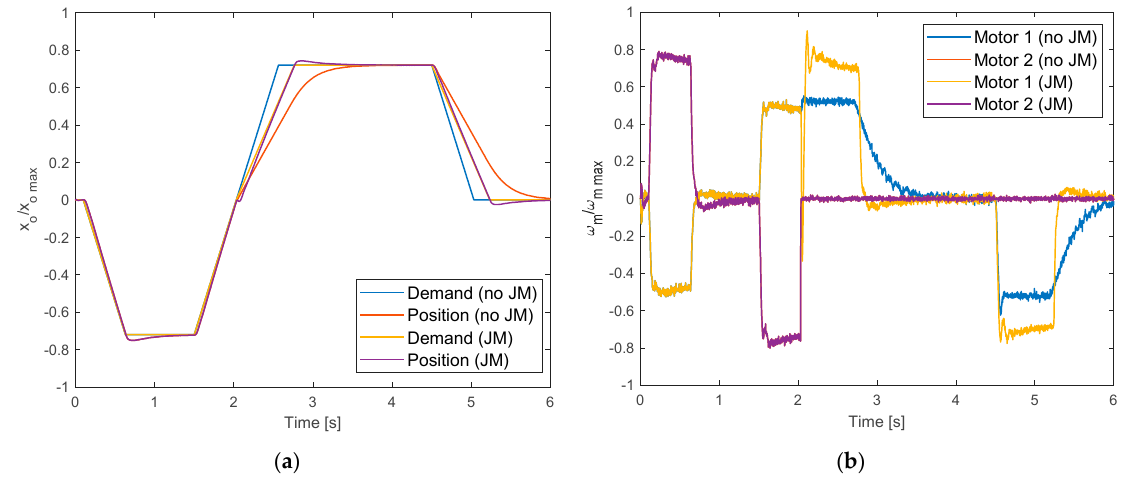
Figure 12. Jamming Monitor (JM) effect with block of motor 2 at 2.03 s (FDI latency = 10 ms): ( a ) output position; ( b ) motors speeds.